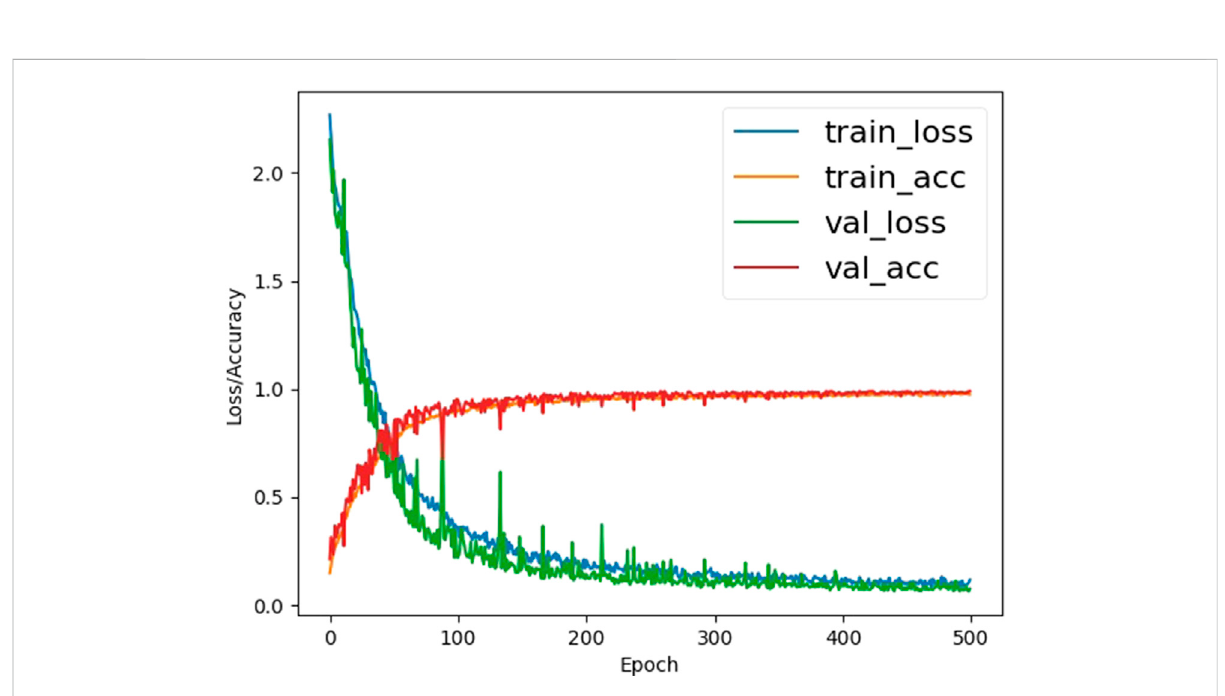
FIGURE 6 Loss and accuracy graph of the training process. The horizontal axis represents epoch and the vertical axis represents loss and accuracy